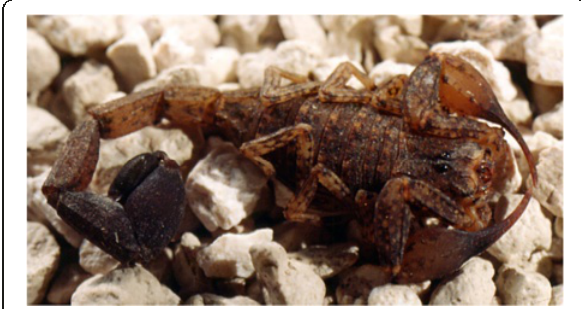
Fig. 19 Tityus ( Archaeotityus ) silvestris Pocock, 1897; male from